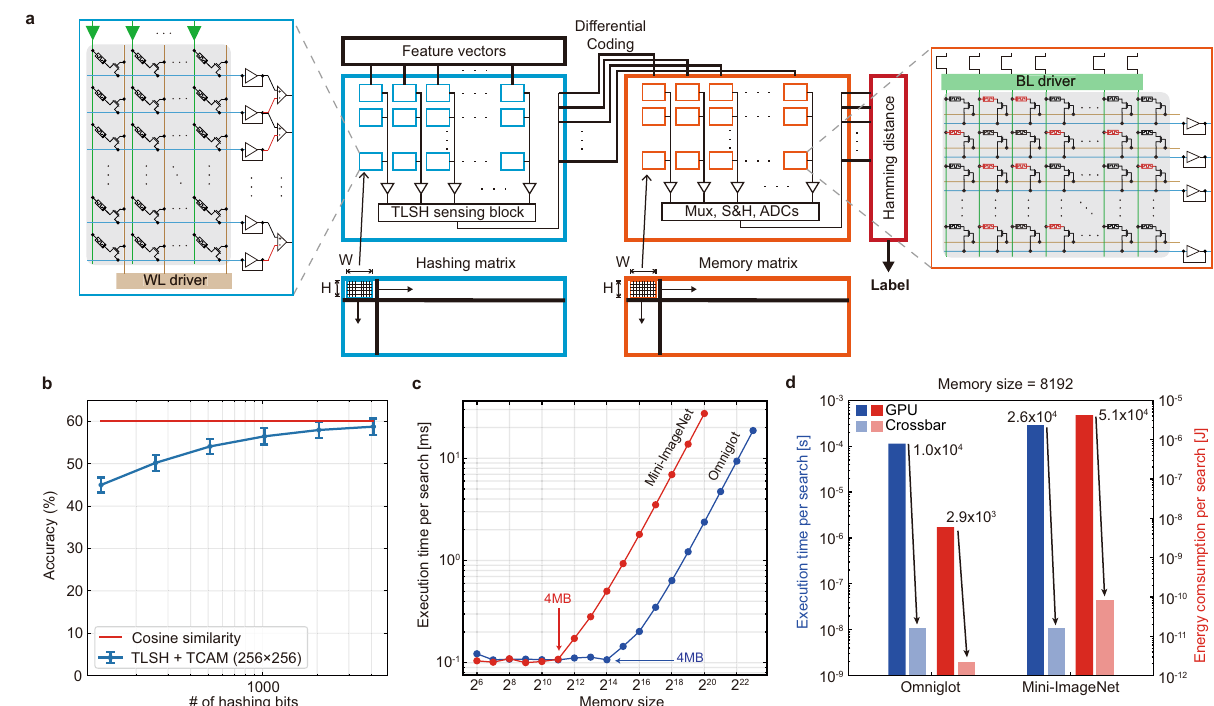
Fig.5|ExperimentvalidatedsimulationresultsofMini-ImageNetdataset.a The architectureofTLSHandTCAMforthescaled-upMANN.Bothmatricesforhashing and external memory are partitioned into H × W memristor crossbar tiles, to miti- gatethevoltagedropprobleminlargecrossbarsandtoincreasetheutilizationrate. b The accuracy performance from our experiment-validated models on Mini- ImageNet dataset. The error bar shows the 95% con fi dence interval among 100 repeated inference experiments. c The execution time of search operations per inference on a GPU drastically increases when external memory size reaches